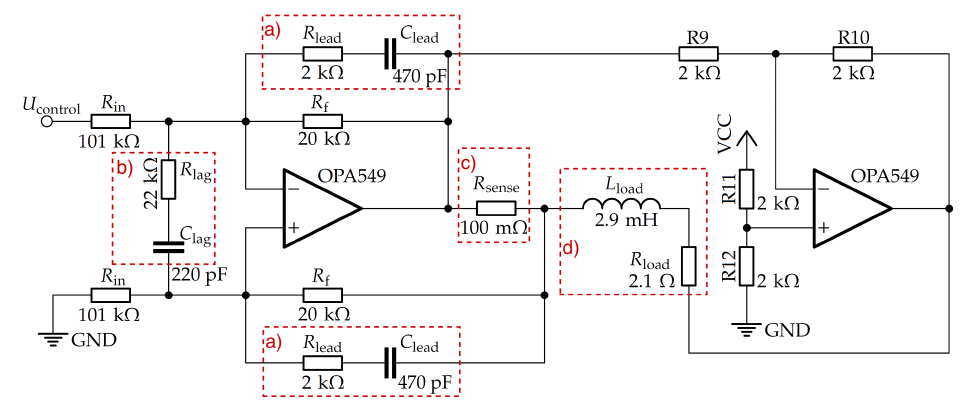
Figure 1. The source section of the push–pull operational amplifier bipolar current source. The main operational amplifiers (OPA549) work interchangeably as a current source and a sink allowing for bidirectional current flow through external coils. The current value is sensed on the R sense resistor, placed in series with L load . The output current is proportional to the input U control voltage referenced to the second input (here, grounded). For the full formula, see Equation (1). ( a ) Parts of the lead compensator for response timing enhancement. ( b ) Parts of the optional lag compensator for enhancing the steady state performance. ( c ) The high power, temperature-stable sense resistor for current measurement. ( d ) External coils with total inductance L load = 2.9mH and total resistance R load = 2.1 Ω